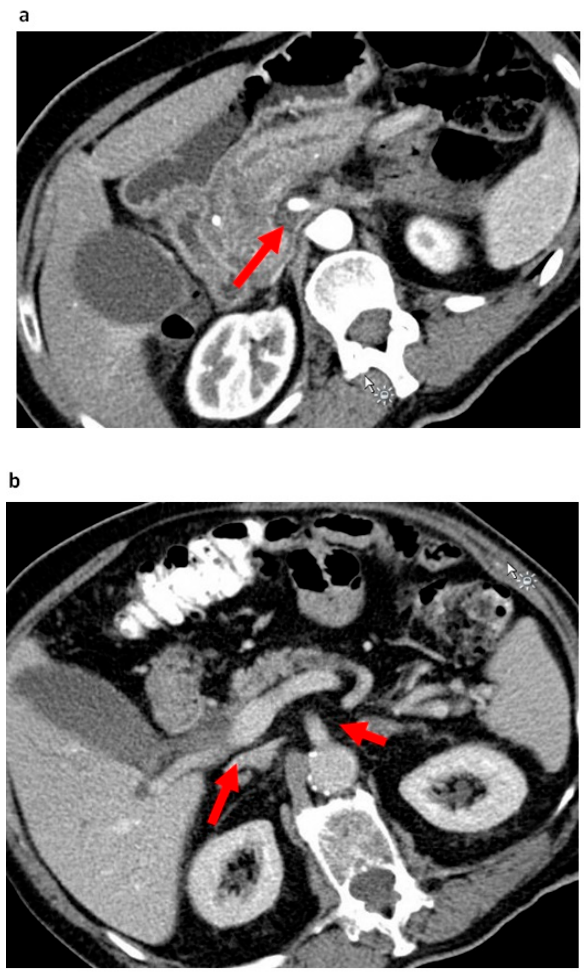
Figure 4. The novel resectability criteria: SMA stranding and superior mesenterico-portal vein alteration (SMPV) alterations. ( a ). Perivascular stranding of the superior mesenteric artery in a patient with pancreatic head cancer; ( b ) Tumor narrowing and distortion of the superior mesenteric vein